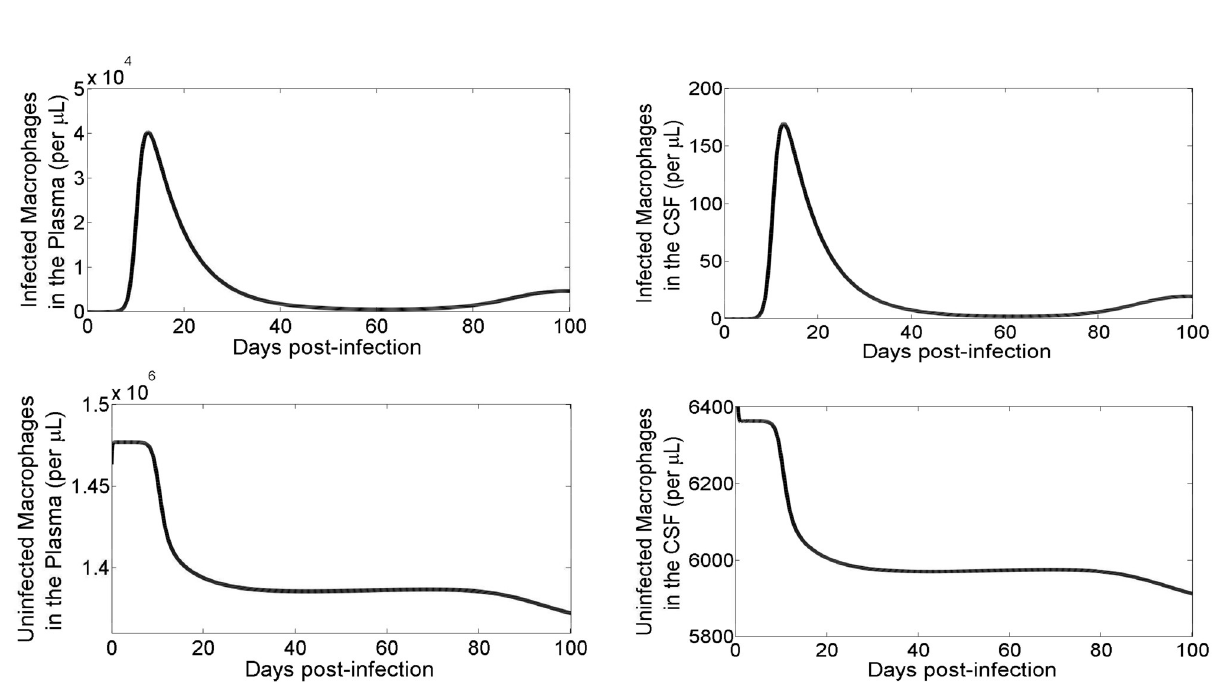
Fig 5. Simulations of macrophages in the plasma and the CSF. Model simulations over 100 days post-infection of infected macrophages (top row) and uninfected macrophages (bottom row) in the plasma (left column) and in the brain (right column).